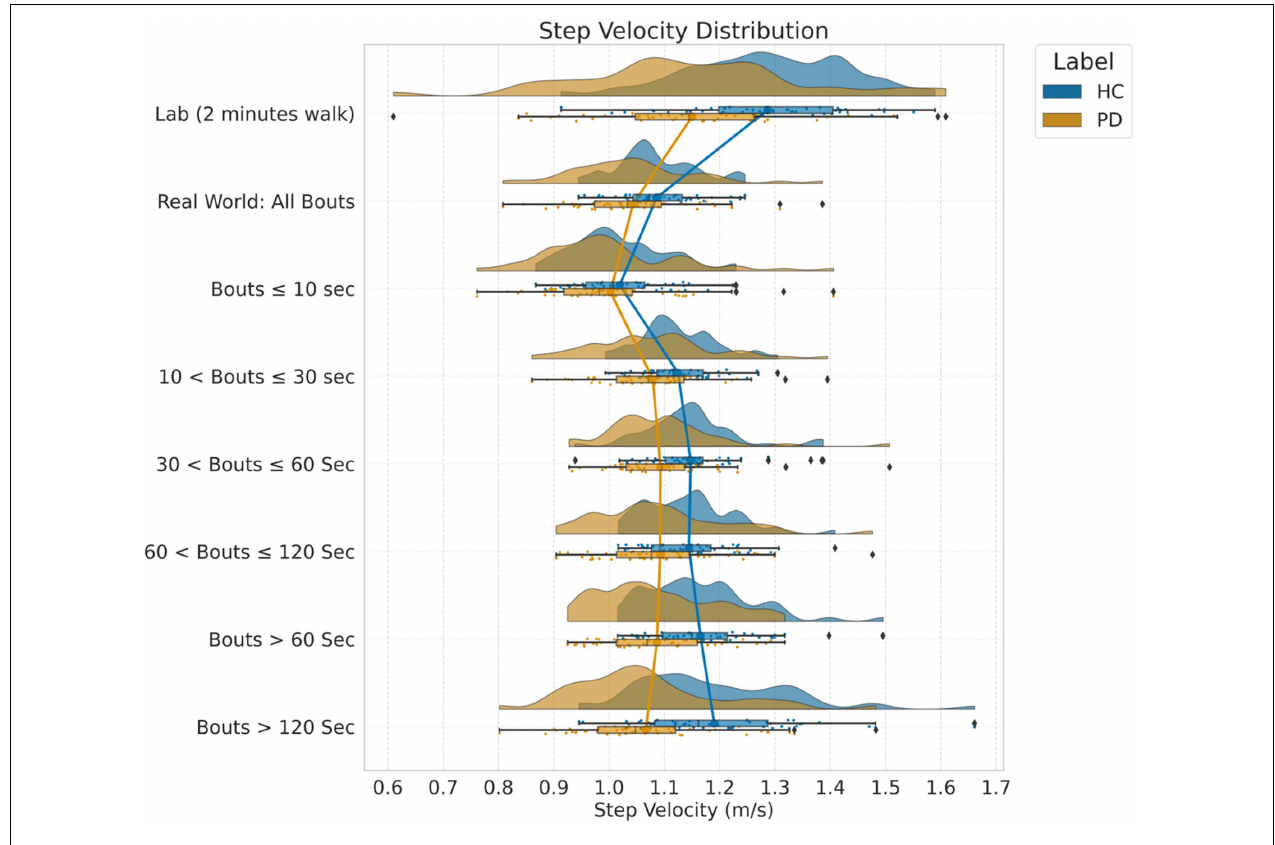
FIGURE 3 | Distribution of step velocity (m/s) into different WB thresholds and average of 7